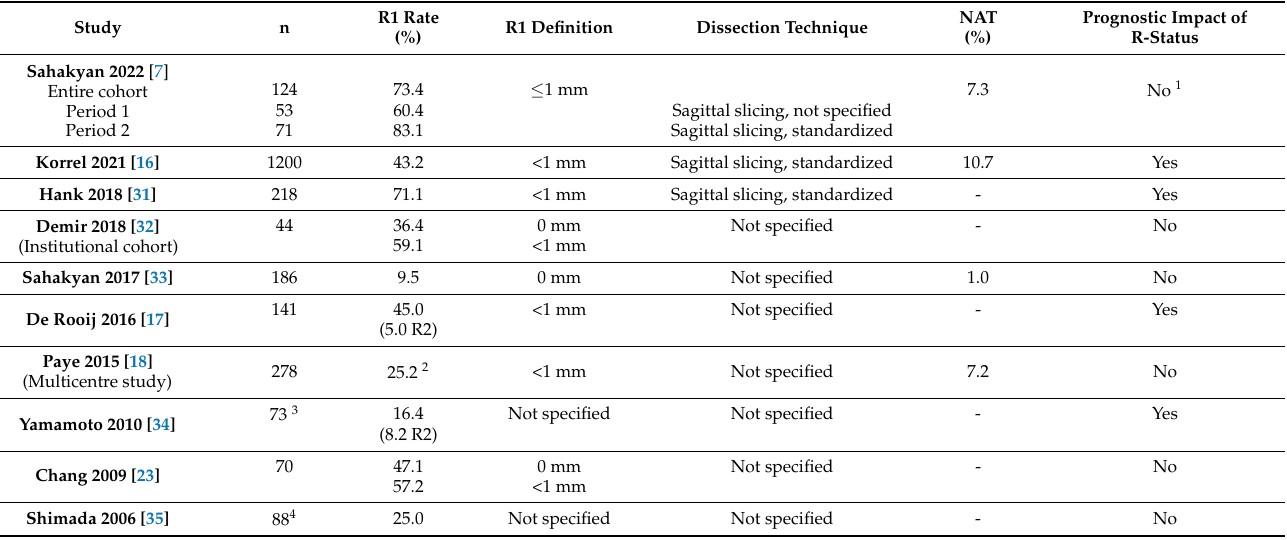
Table 2. Studies that investigated the prognostic impact of resection margin status in distal pancreate- ctomy specimens. Only studies based on a cohort size of more than n = 40 and a study period later than 2006 are